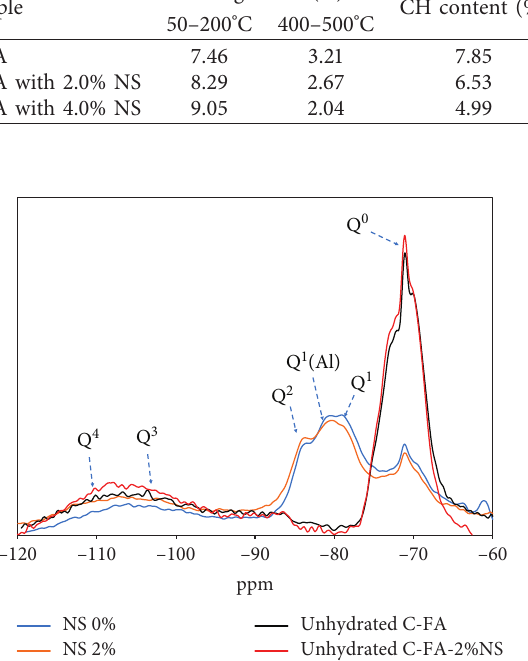
Figure 11: 29 Si-NMR pattern of paste hydrated for